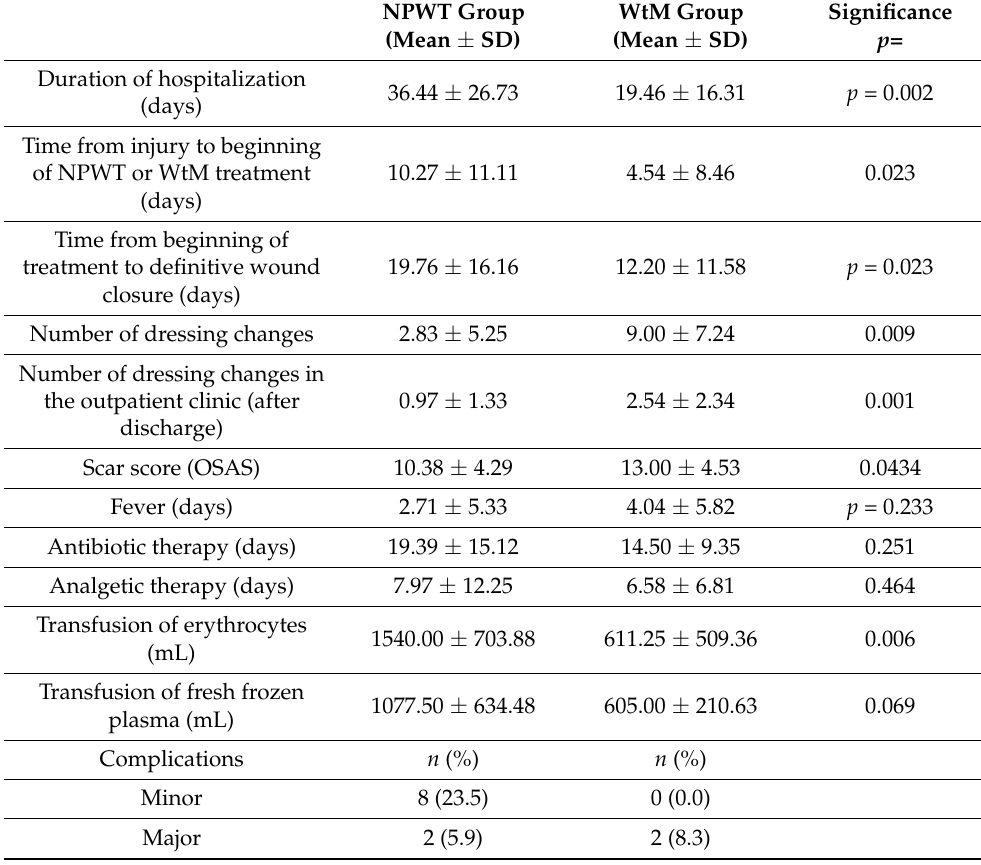
Table 3. Treatment overview.